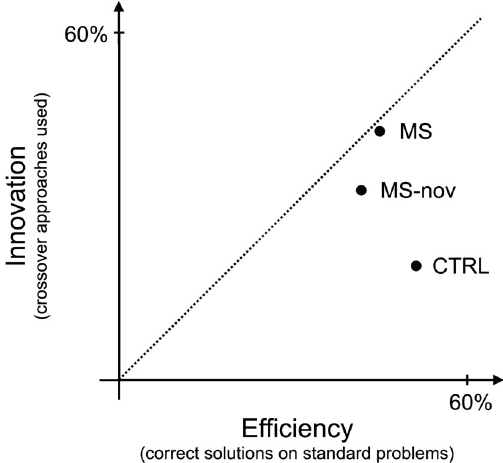
FIG. 9. Plot of the study results by innovation vs efficiency. The dotted line represents a balance of equal levels of efficiency and innovation. The MS student average is closest to this line whereas the CTRL student average is furthest from this